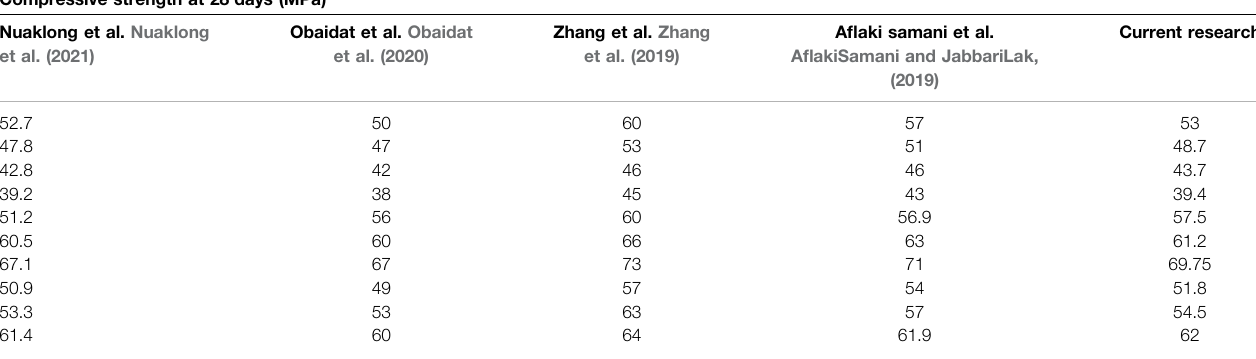
TABLE 5 | Values of compressive strength from present literature and the current